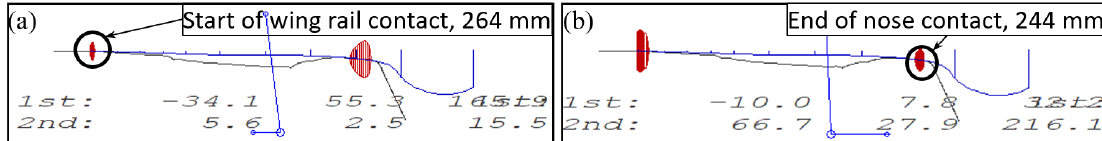
Figure 25. Transition region calculation of a 1:9 trailing crossing using the measured rail geometry: ( a ) start of the contact with the wing rail and ( b ) end of the contact with the nose rail.